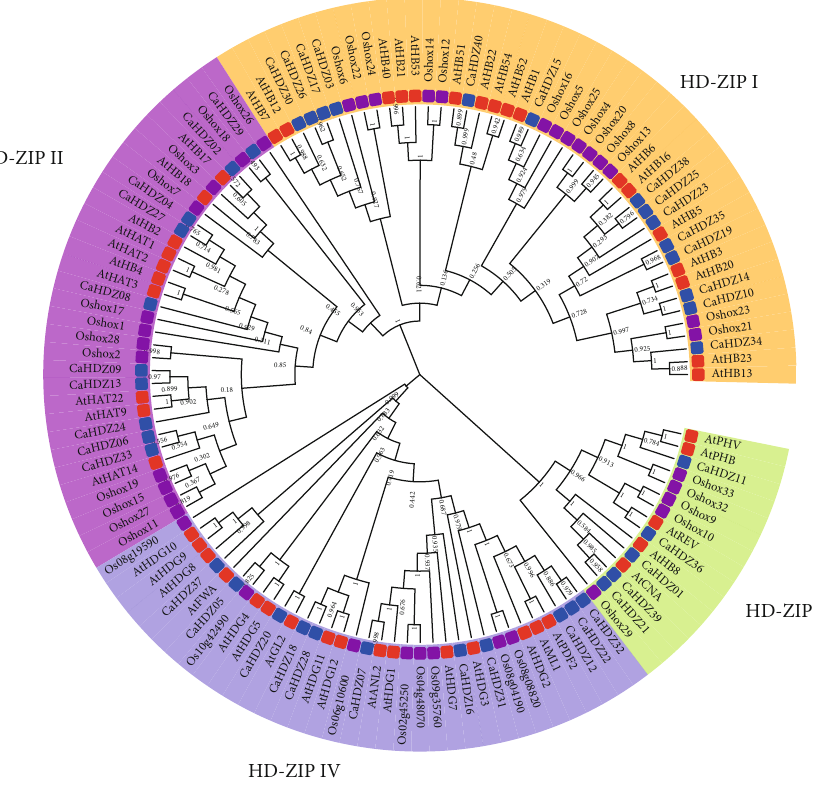
Figure 7: Phylogenetic trees of 132 HD-ZIP proteins in pepper (blue square), Arabidopsis (red square), and rice (purple square). The HD-ZIP gene is divided into four subfamilies (groups I, II, III, and IV, with yellow, purple, green, and blue branches,